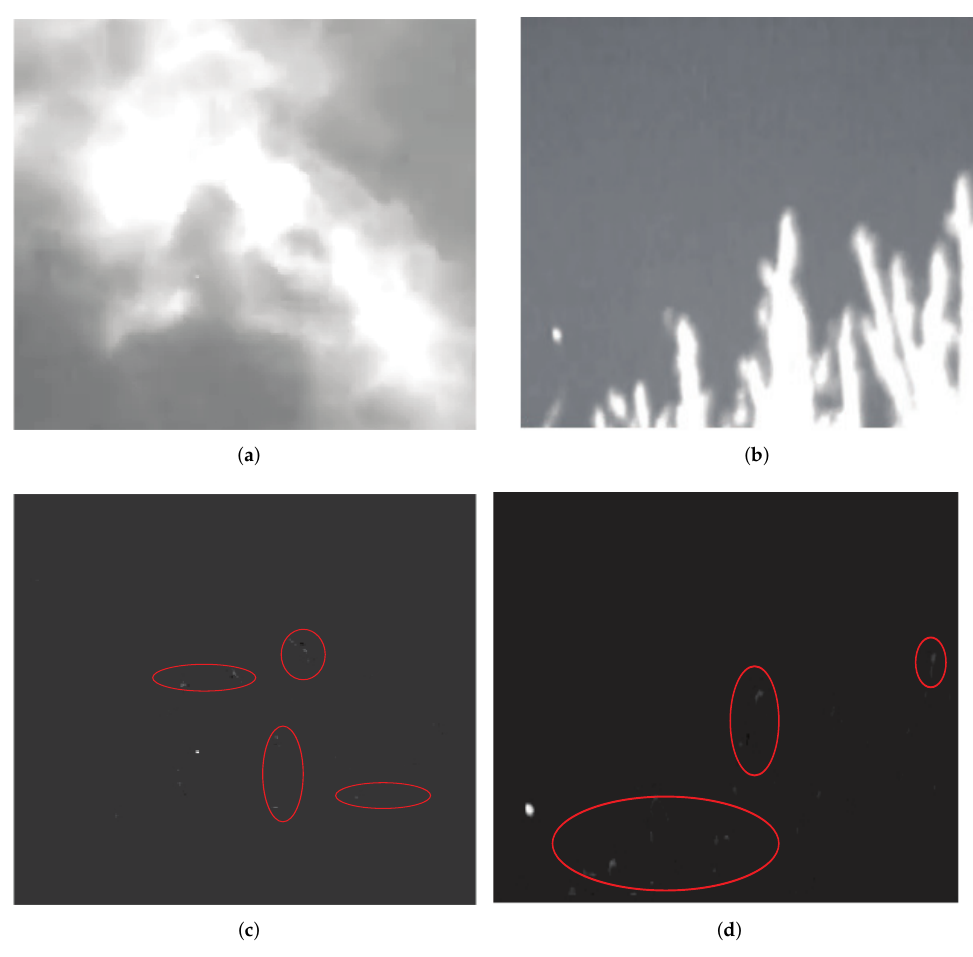
Figure 2. The IPI model detection results. ( a , b ) original images. ( c , d ) target images with clutter. According to the background structure information, the low-rank term is weighted to suppress the staircase effect so as to accurately characterize the image background feature and obtain a clear background estimation. First, the matrix Q is converted into patch image Q . Then, the following weight equation is obtained by the OEI of the infrared image: